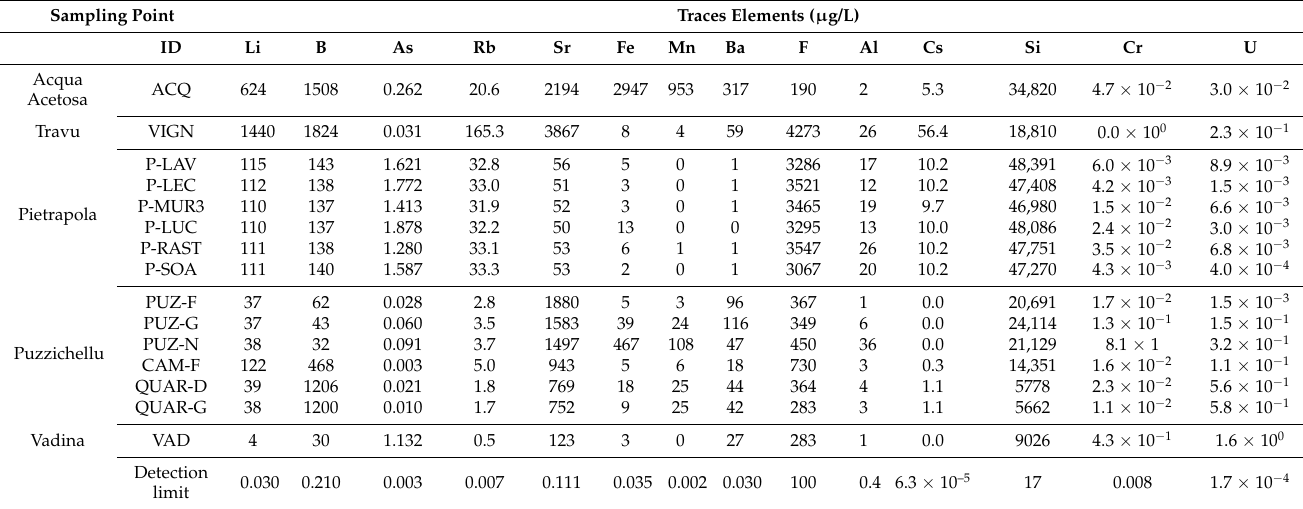
Table 3. Concentrations in trace